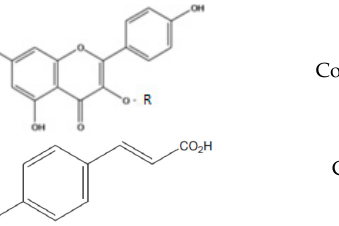
Figure 2. HPLC/DAD profile of BB Romanian, July 2016, corresponding to 97% of Brassica napus L. pollen as taxon origin. Compounds 1 and 2 are Kaempferol-3- O- derivatives and compounds 3 – 7 are Hydroxycinnamic acids derivatives (data in line with Campos and Markham [34]).